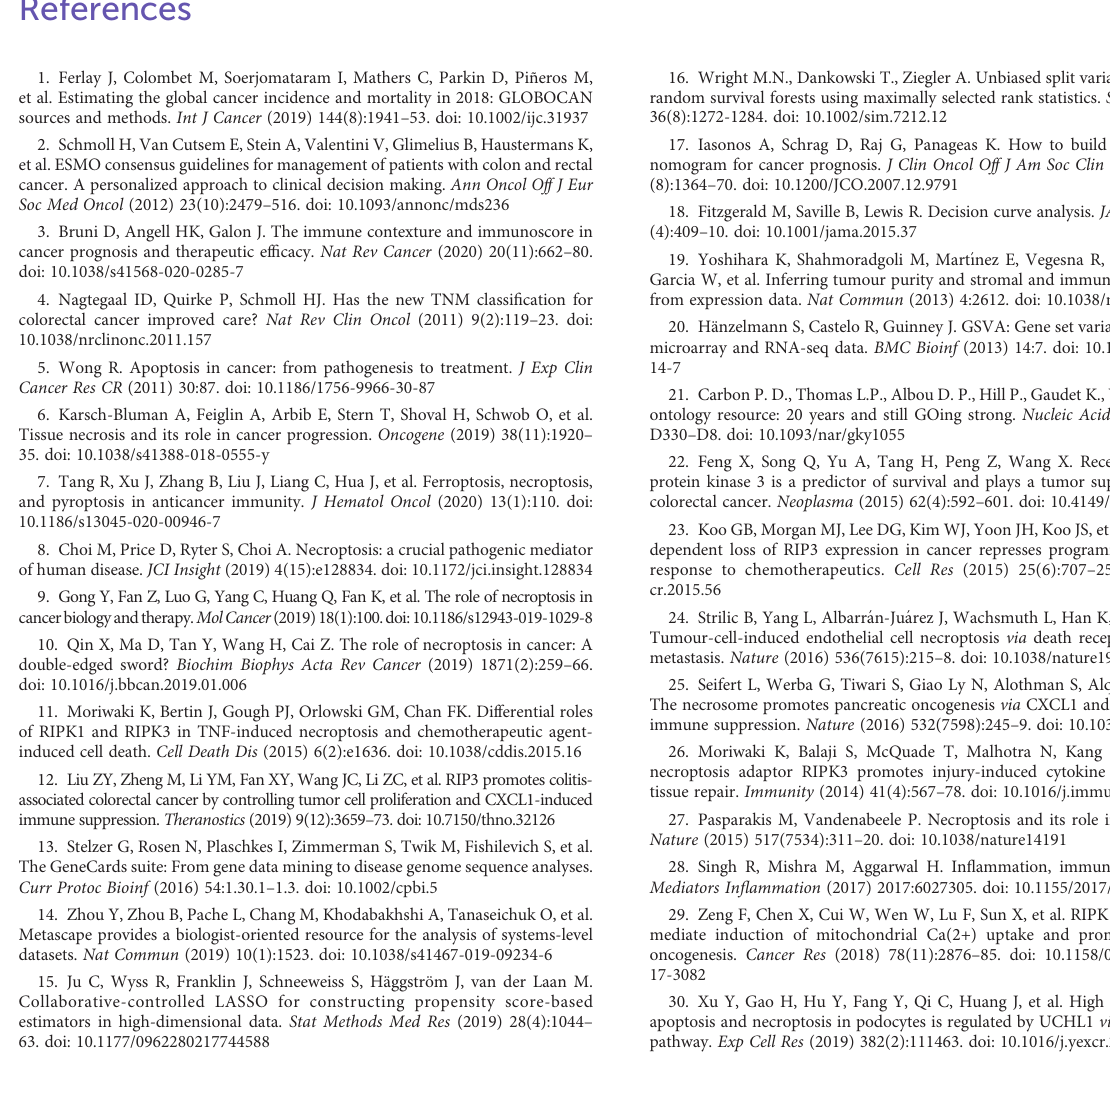
SUPPLEMENTARY DATA SHEET S3 The detailed results of functional enrichment analysis.